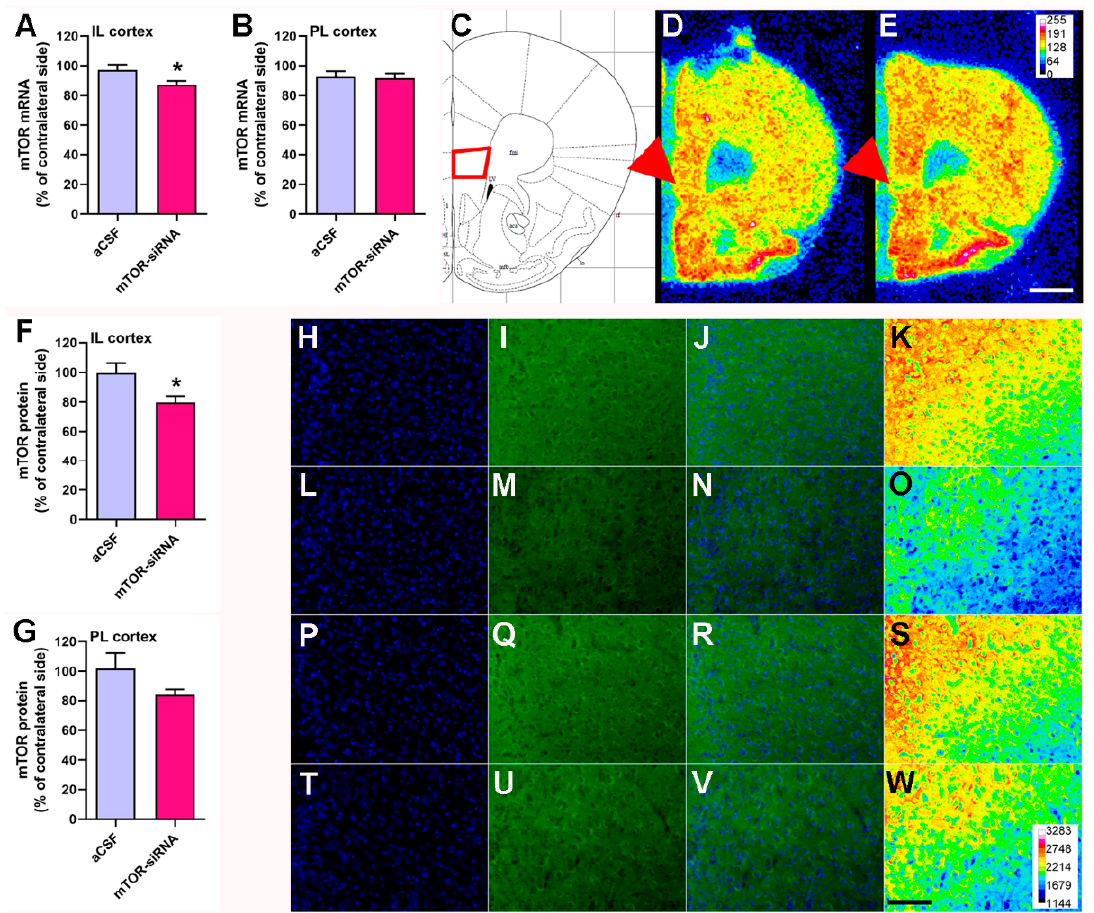
Figure 2. mTOR downregulation after intracerebral administration of siRNAs targeting mTOR in the infralimbic cortex ( C ). mTOR levels in ( A , F ), the IL, and ( B , G ) the PrL cortex were evaluated by ( A – E ) in situ hybridization, and ( F – W ) mTOR protein expression by immunofluorescence, after unilateral infusion into the IL cortex. Data are expressed as mean ± S.E.M. Unpaired Student’s t -test, * p < 0.05. n = 4–5 animals per group. Representative coronal brain sections containing IL cortex showing mTOR mRNA expression in ( D ) aCSF-infused and ( E ) mTOR-siRNA-infused mice as assessed by in situ hybridization. Representative immunofluorescent images of the mTOR protein levels in ( H – K ) the IL and ( P – S ) the PrL cortex of vehicle-infused mice, and in ( L – O ) the IL and ( T – W ) the PrL cortex of mTOR-siRNA-infused mice. Images show ( H , L , P , T ) DAPI, ( I , M , Q , U ) mTOR, ( J , N , R , V ) merged, and ( K , O , S , W ) heat-map image. Scale bar in E: 1 mm. Scale bar in W: 100 µ m. Heat-map calibration bar in E and W showing the intensity values. aCSF: artificial cerebrospinal fluid; IL: infralimbic; PrL: prelimbic; siRNA: small interfering RNA.